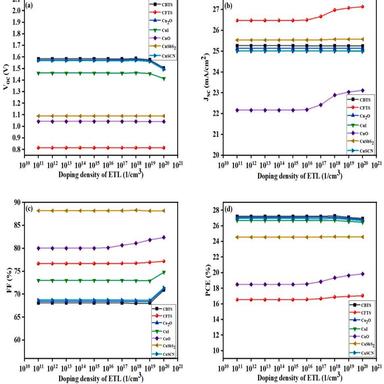
Doping density of ETL ZnSe versus SC performance parameters.